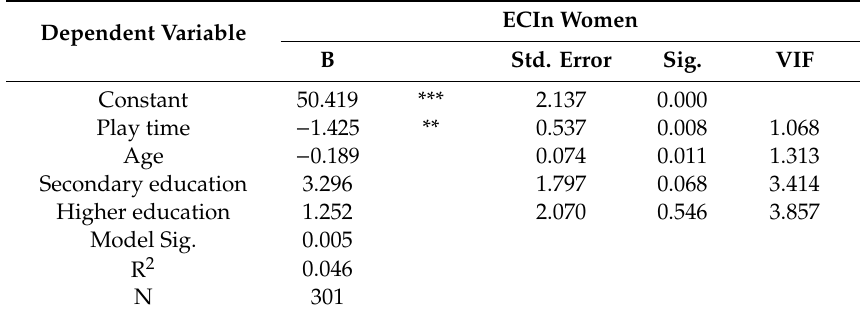
Table 4. The association of the novelty component of ECI (ECIn) and play time in women. Results of the multivariate regression analysis.